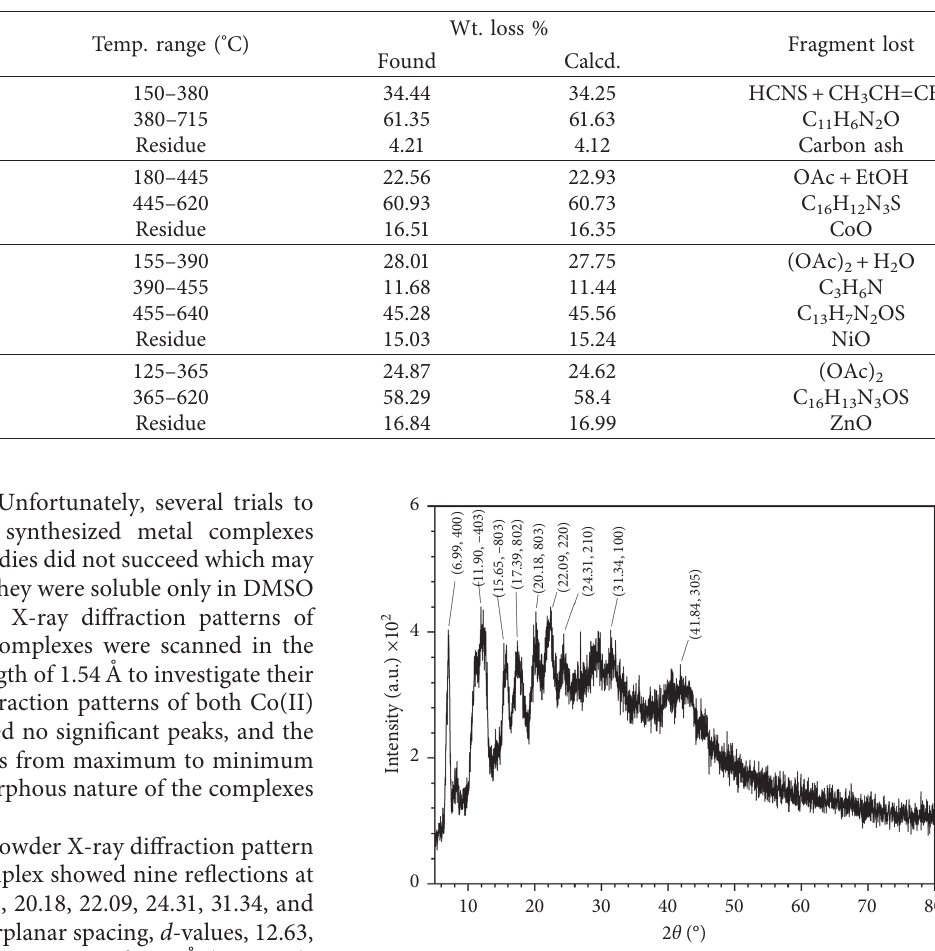
Table 4: Thermal gravimetric analysis of HAAT and its complexes.